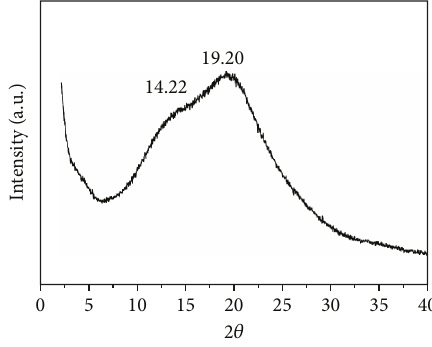
Figure 5: X-ray di ff raction patterns of polymer sample 2 in Table